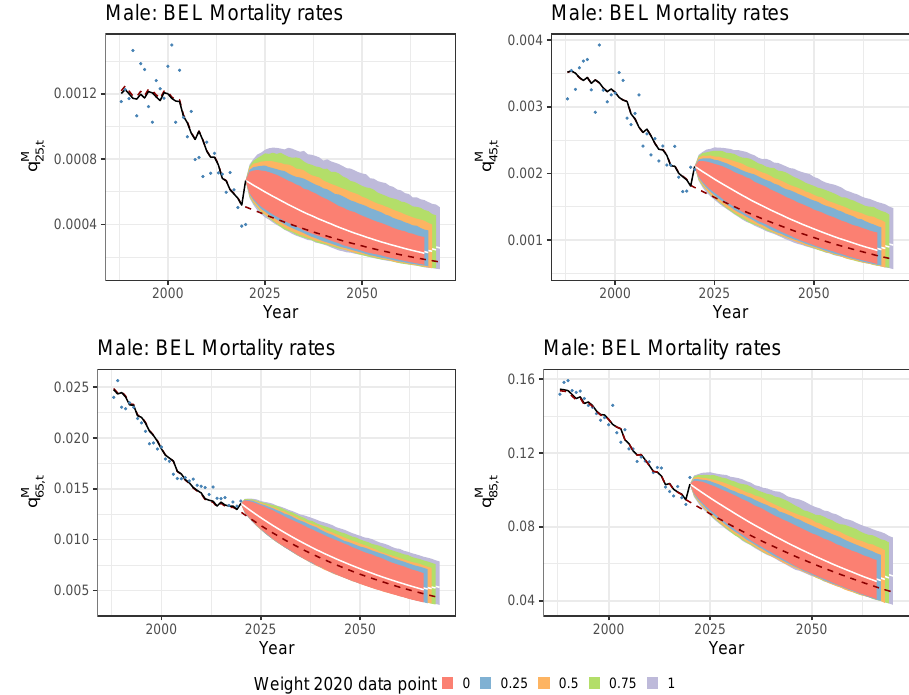
Figure 9. Estimated and projected Belgian mortality rates ˆ q x , t . Male data, ages 25, 45 ( top ) and 65, 85 ( bottom ), calibration period 1988–2020, projection period 2021–2070, method of Section 5.1. We show the 0.5%, median (white lines) and 99.5% quantile, based on 10,000 simulations across each weighting scenario. The blue dots and the black lines represent the observed and fitted mortality rates, respectively. The dark red, dashed line shows the calibrated mortality rates and the median quantile of the simulations in the original IA | BE 2020